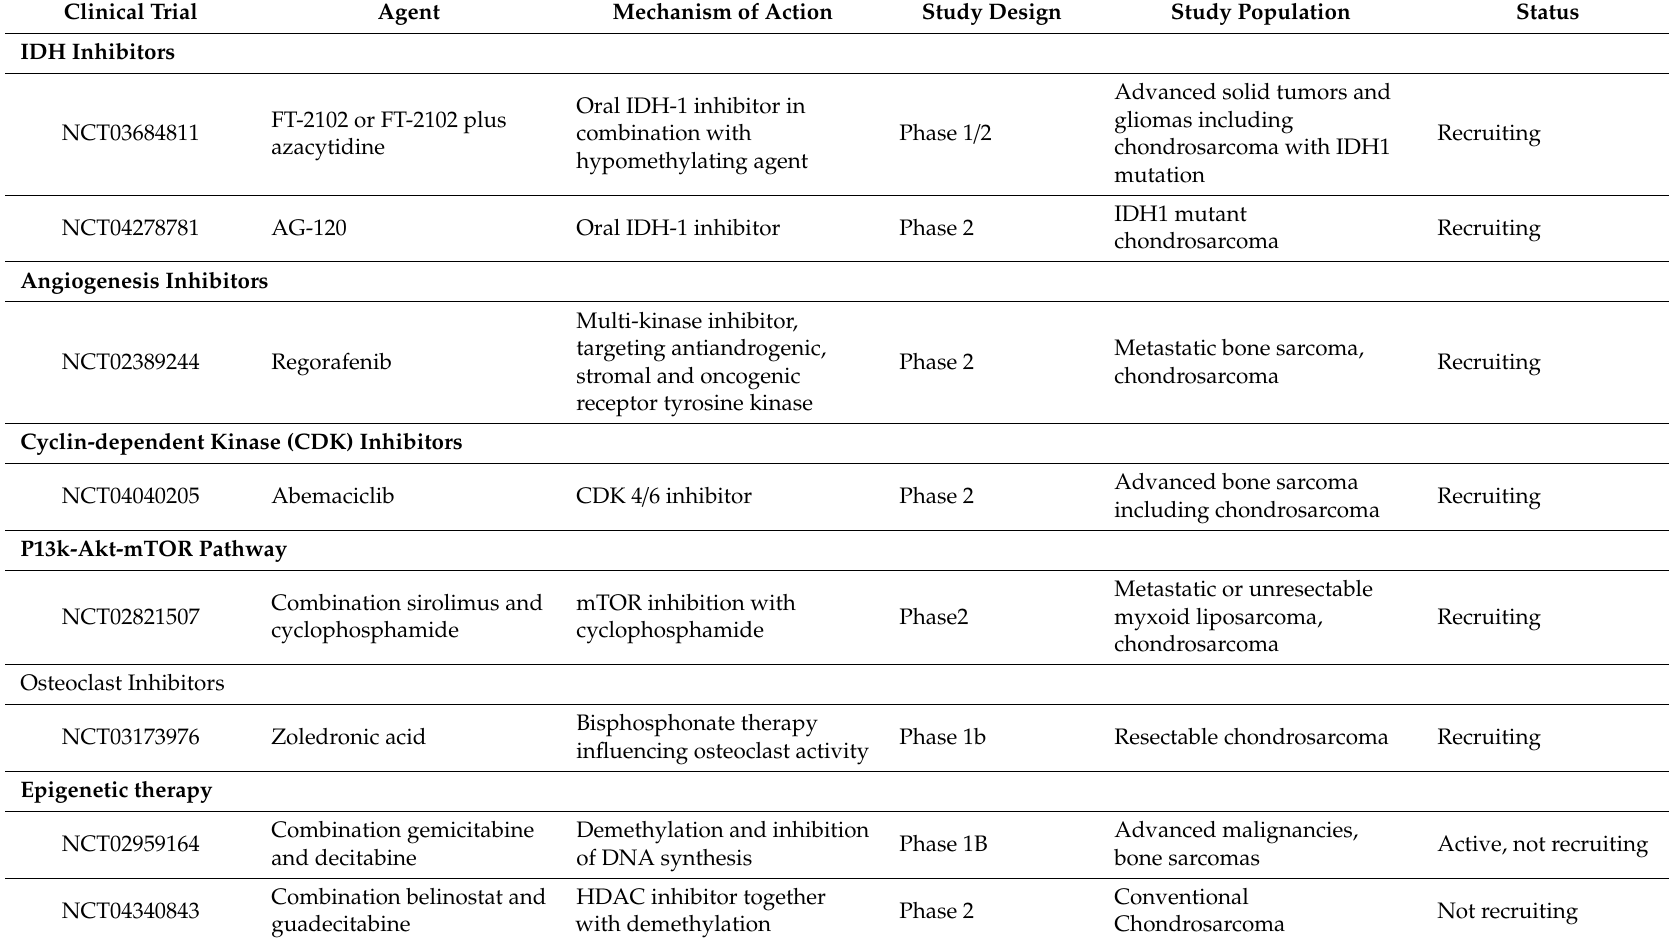
Table 1. Current clinical trials for conventional chondrosarcoma (March